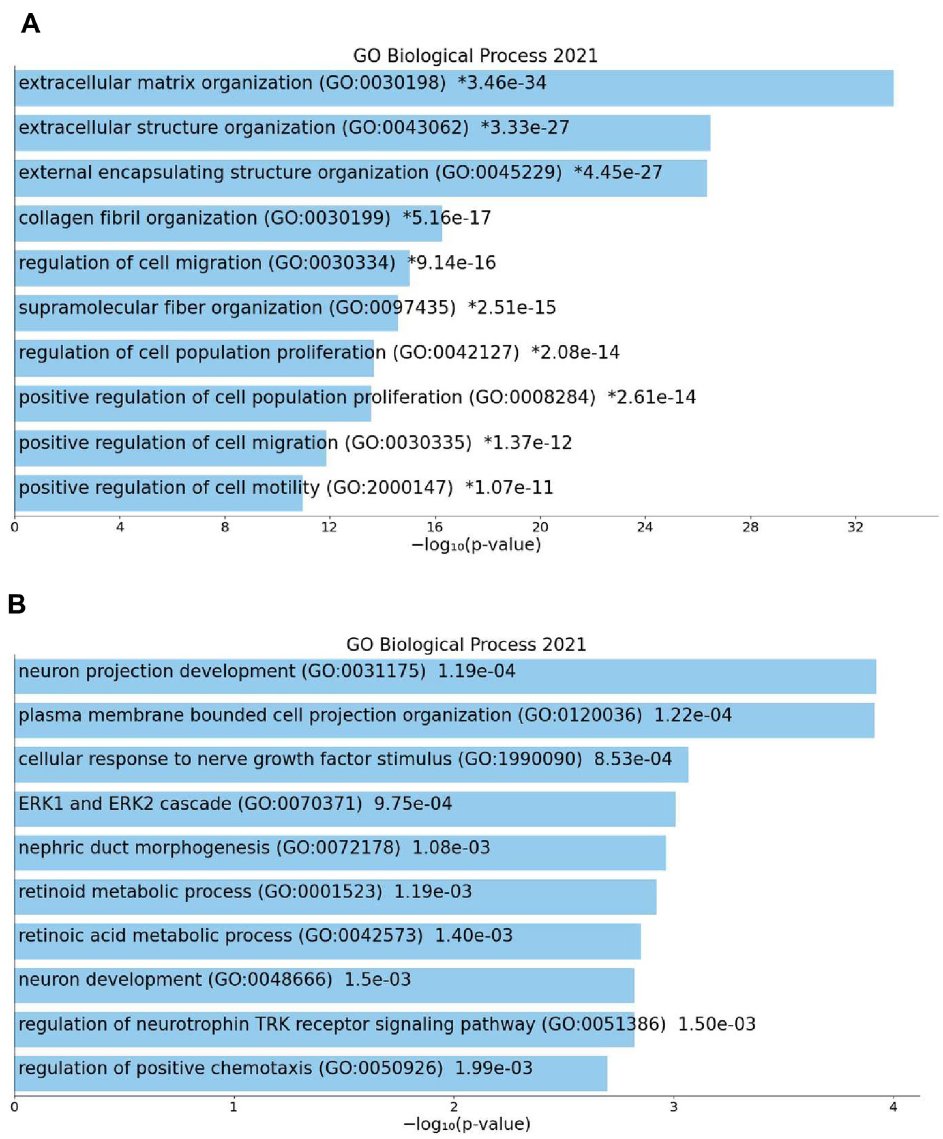
Fig 4. Go Biological process analysis of genes expressed in common in IPC (clusters 2, 9, 10, 11, 12, [32]) and Wilms cells and those that are exclusively expressed in normal IPC. A ) The top 10 enriched Biological processes of genes expressed in common in both. B) The top 10 enriched biological terms that are exclusive for normal